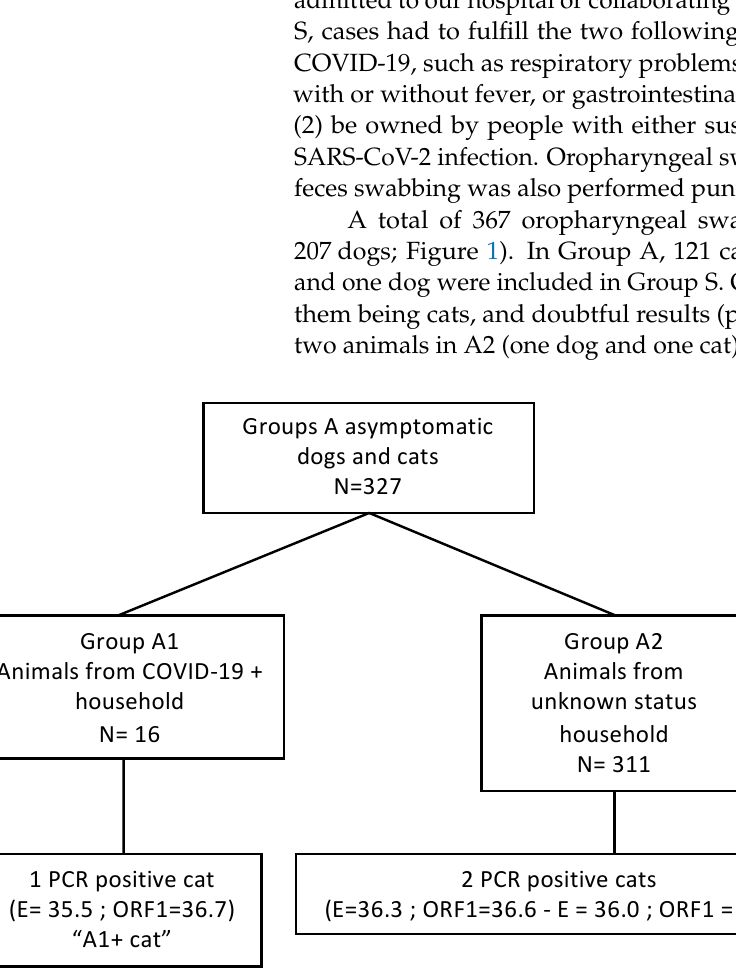
Figure 1. Prospective survey results. Group composition and number of positive animals are displayed. Ct value for targeted genes (E and Orf1) is indicated for positive animals. “A1+ cat” and “S1+ cat” refer to the 2 positive animals with detailed clinical and virological data.